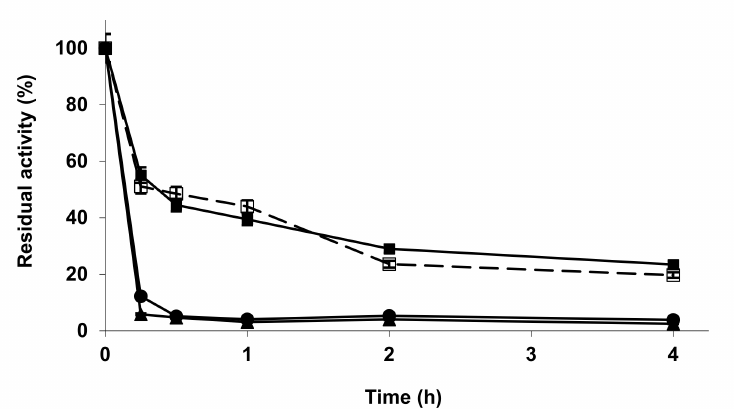
Figure 1. Inactivation courses of TLL-IM unmodified and modified with metallic salt/sodium phosphate. The inactivation was performed with 10 mM Tris buffer at pH 7.0 and 75 ◦ C. Other specifications are described in the Methods section. Unmodified TLL-IM (open squares and dotted line); TLL-IM modified with ZnCl 2 /sodium phosphate (solid squares); CuCl 2 /sodium phosphate (solid circles); CoCl 2 /sodium phosphate (solid